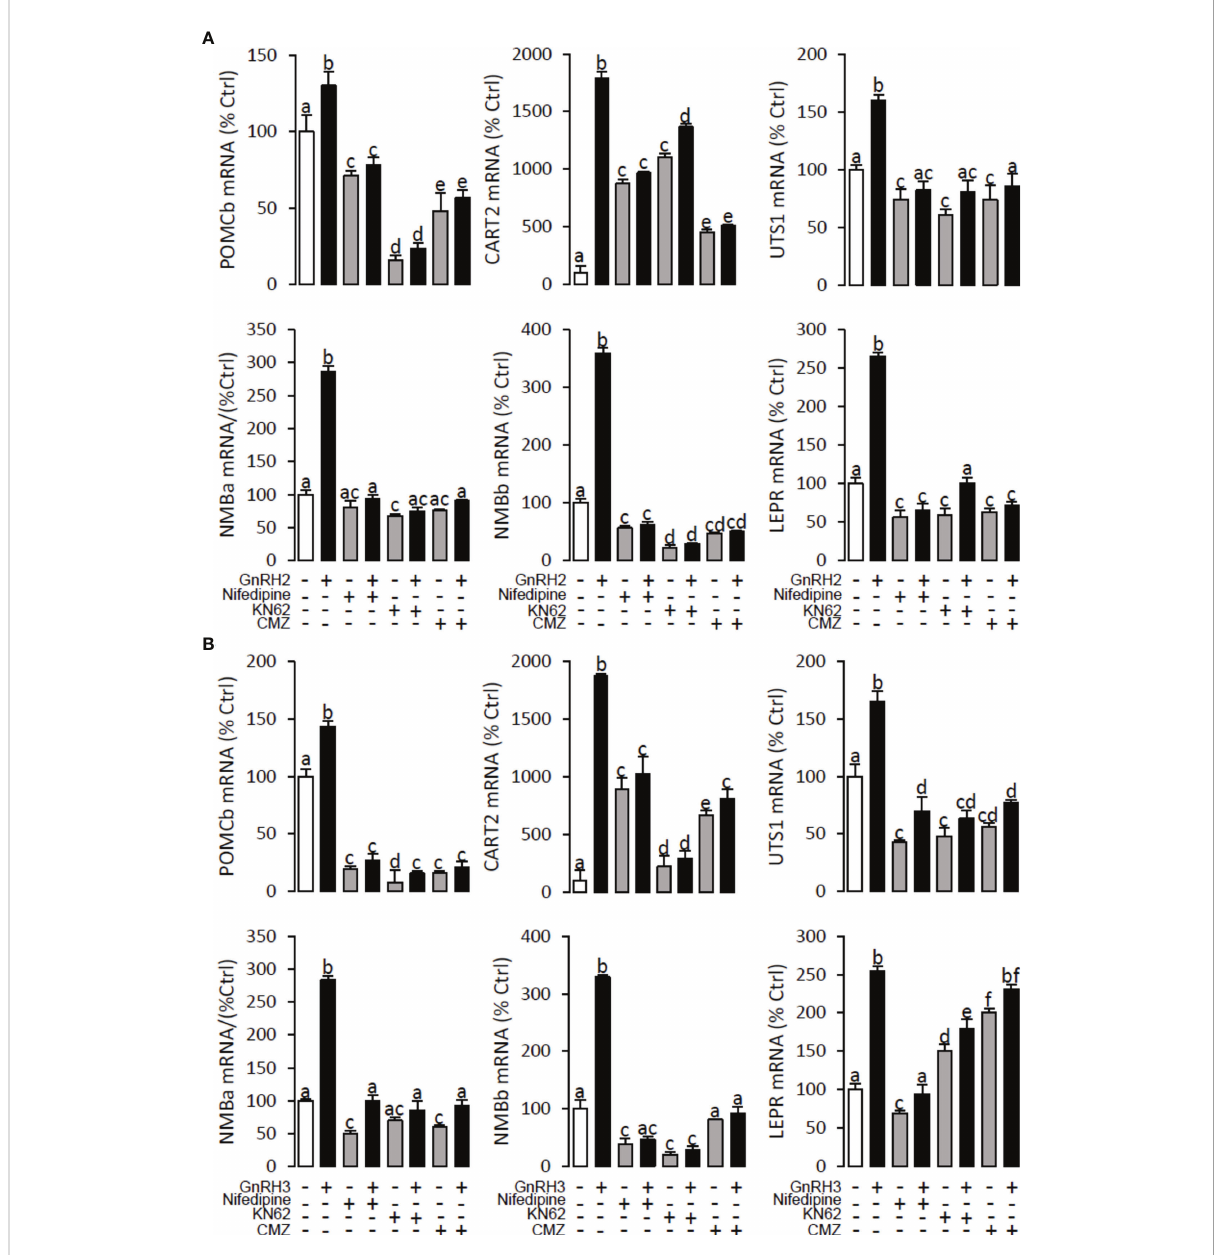
FIGURE 12 Signal transduction for GnRH2- and GnRH3-induced POMCb, CART2, UTS1, NMBa, NMBb, and LEPR mRNA expression in grass carp pituitary cells. In this experiment, GnRH2 (A) or GnRH3 (B) combined with / without the VSCC inhibitor nifedipine (10 m M), CaM antagonist calmidazolium (1 m M), or CaMK-II blocker KN62 (5 m M) were used to incubate the grass carp pituitary cells for 24 (h) After drug treatment, the total RNA was extracted from the cells for real-time PCR of the respective genes. Data presented are expressed as mean ± SEM, and the differences between groups were signi fi cant at p < 0.05 by labelling diverse letters (ANOVA followed by a Dunnett